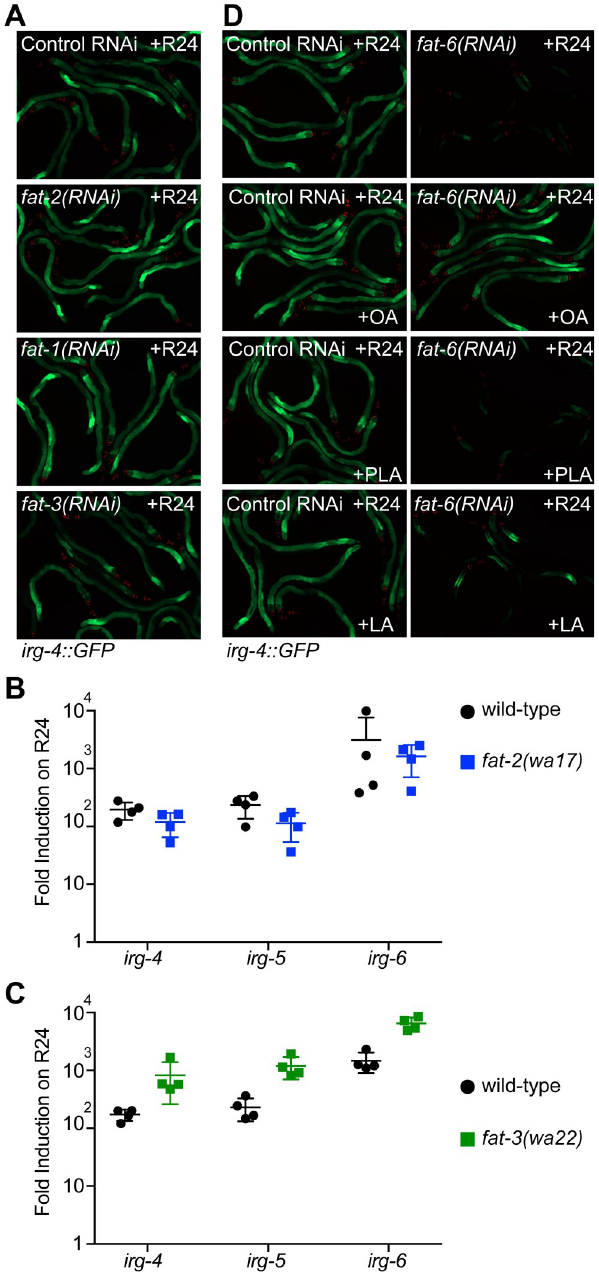
Fig 2. Polyunsaturated fatty acids are not required for immune induction by the immunostimulatory small molecule R24. A. C . elegans irg-4 :: GFP immune reporter animals were fed the indicated RNAi bacteria and transferred at the L4 stage to plates containing R24 for approximately 18 hours. B and C. Expression of the immune effectors irg-4 , irg-5 , and irg-6 were determined using qRT-PCR in wild-type, fat-2(wa17) , and fat-3(wa22) mutant animals exposed to R24 or the solvent control (DMSO) for six hours. Data are the average of four independent replicates, each normalized to a control gene and presented as fold induction in R24-exposed vs. solvent control-exposed animals in the indicated genetic background. Error bars show standard deviation. Significance was determined by t -tests. There was no significant difference in the R24-mediated induction of the indicated gene in fat-2(wa17) animals or in fat-3 (wa22) mutants for irg-4 . In fat-3(wa22) animals, the induction of irg-5 and irg-6 by R24 was significantly higher than in wild-type (p < 0.001). D. C . elegans irg-4 :: GFP immune reporter animals were fed control or fat-6(RNAi) bacteria seeded on plates containing control or 500 μ M of the indicated fatty acid. PLA is palmitoleic acid and LA is linoleic acid. The animals were then transferred at the L4 stage to plates containing R24 for approximately 18 hours. The presence of the transgene is confirmed by red pharyngeal expression of the myo-2 :: mCherry co-injection marker.